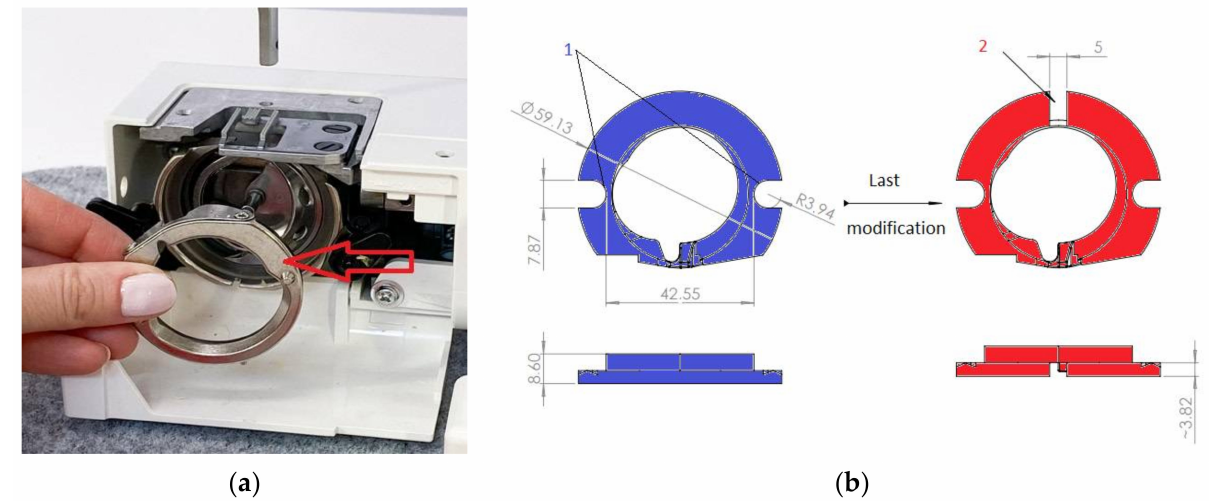
Figure 3. Bobbing case analyzed. ( a ) A view of the original bobbin case; ( b ) Two grooves 1 made during earlier modifications and the one groove 2 made after last modification of the bobbin case (units in mm).